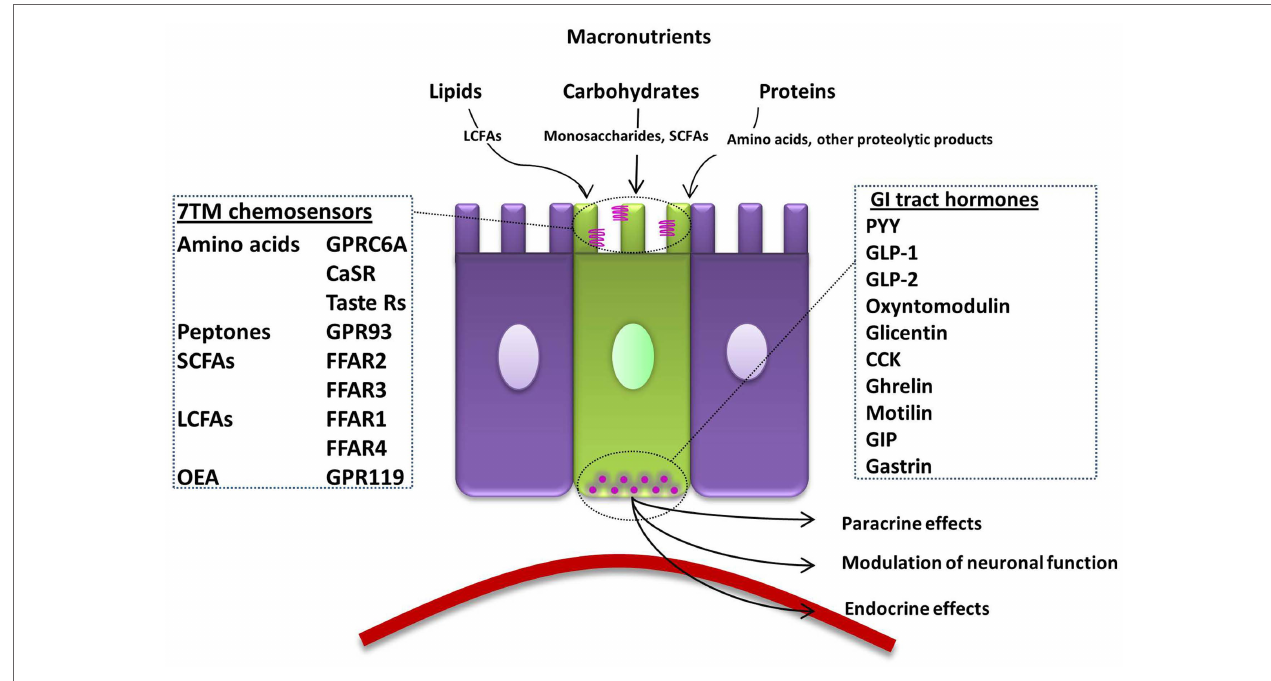
FiGURe 1 | Summary of the macronutrient sensing receptors expressed in enteroendocrine cells of the gut and the hormones they release . An open-type enteroendocrine cell possesses microvilli extending into the gut lumen, coming into direct contact with macronutrients. Food components are sensed by various GPCRs and transporters located on the apical border. GI tract hormones are released into the circulation, acting via paracrine, endocrine, and neural pathways